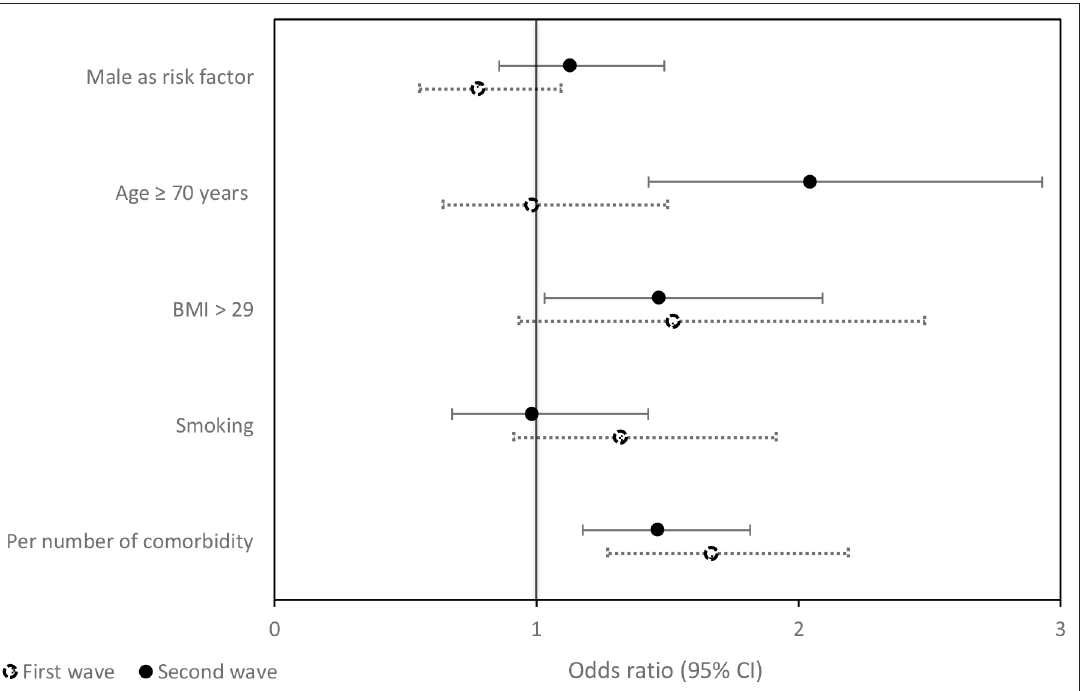
Figure 1 Risk factors associated with receiving an antibiotic prescription. BMI = body mass index. CI = confidence interval. Multivariate logistic regression was performed with pooled imputed data and outcomes were adjusted for all risk